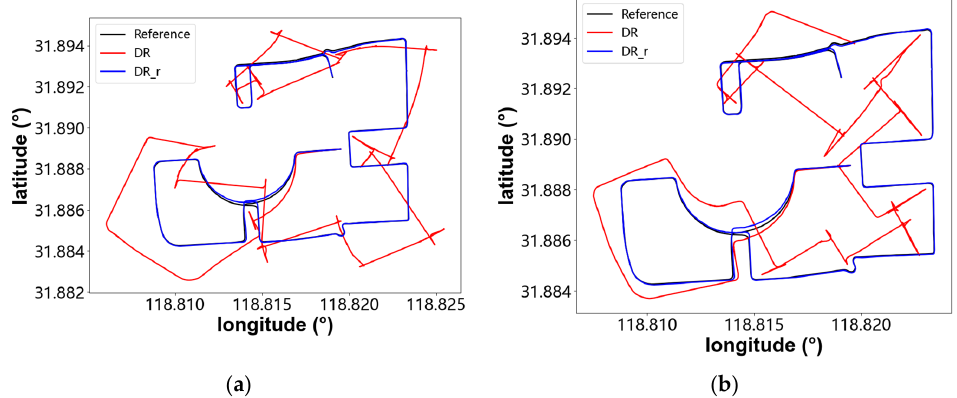
Figure 9. Horizontal positioning trajectory comparison. ( a ) Smartphone Huawei P30; ( b ) Smartphone Huawei P40.